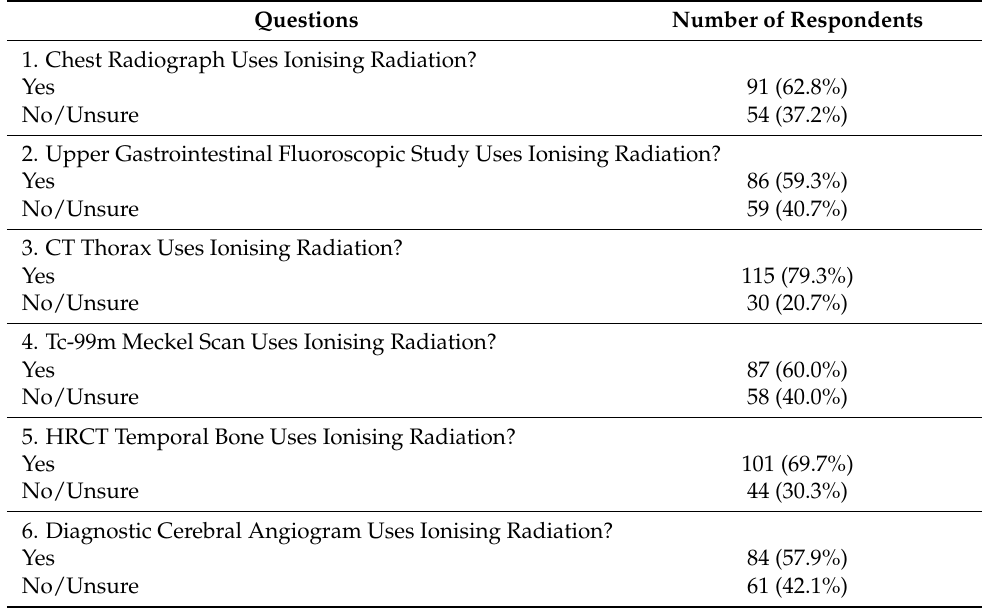
Table 2. Summary of questionnaire responses on ionizing radiation-related medical imaging.